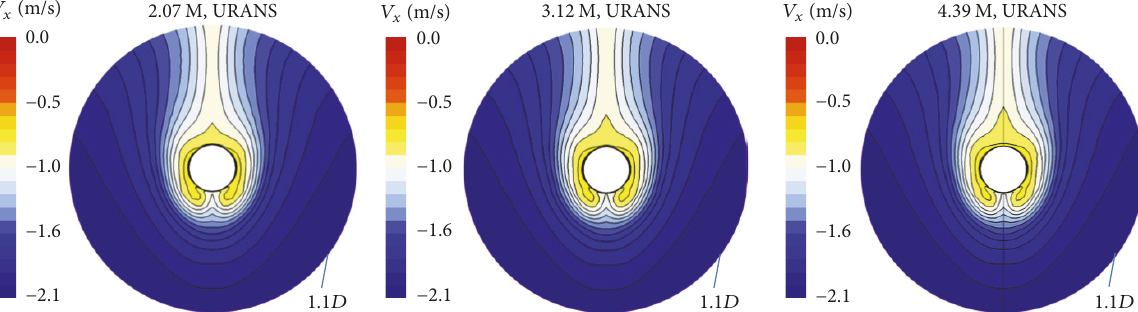
− 2.1 Figure 9: Predicted axial velocity at the propeller plane by URANS with different mesh resolutions.